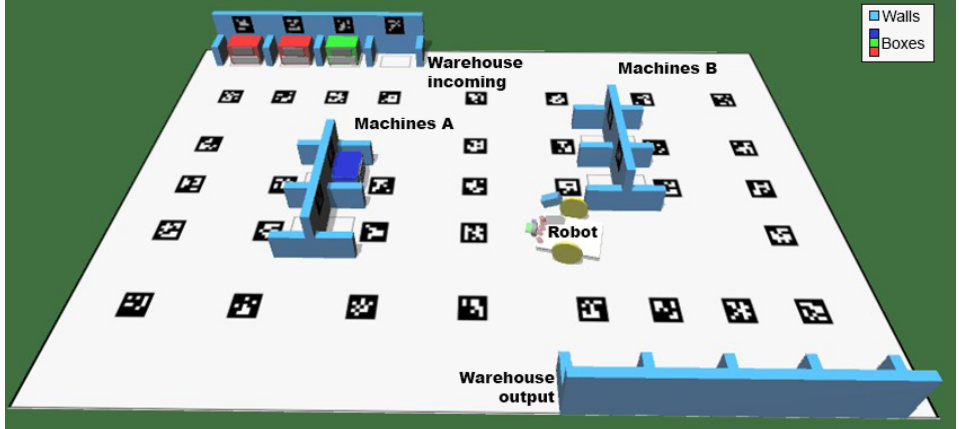
Figure 4. Simulation scene that displays the robot and the environment, where the robot can move and take pictures. The walls, machines, and robot are displayed in the figure with subtitles beside